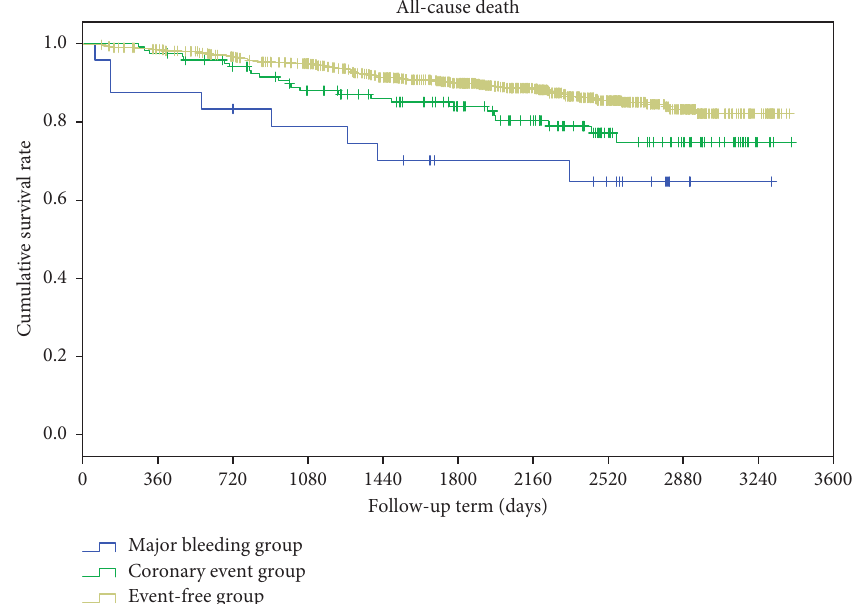
Figure 3: Kaplan–Meier analysis of survival rates of the major bleeding group, coronary event group, and event-free